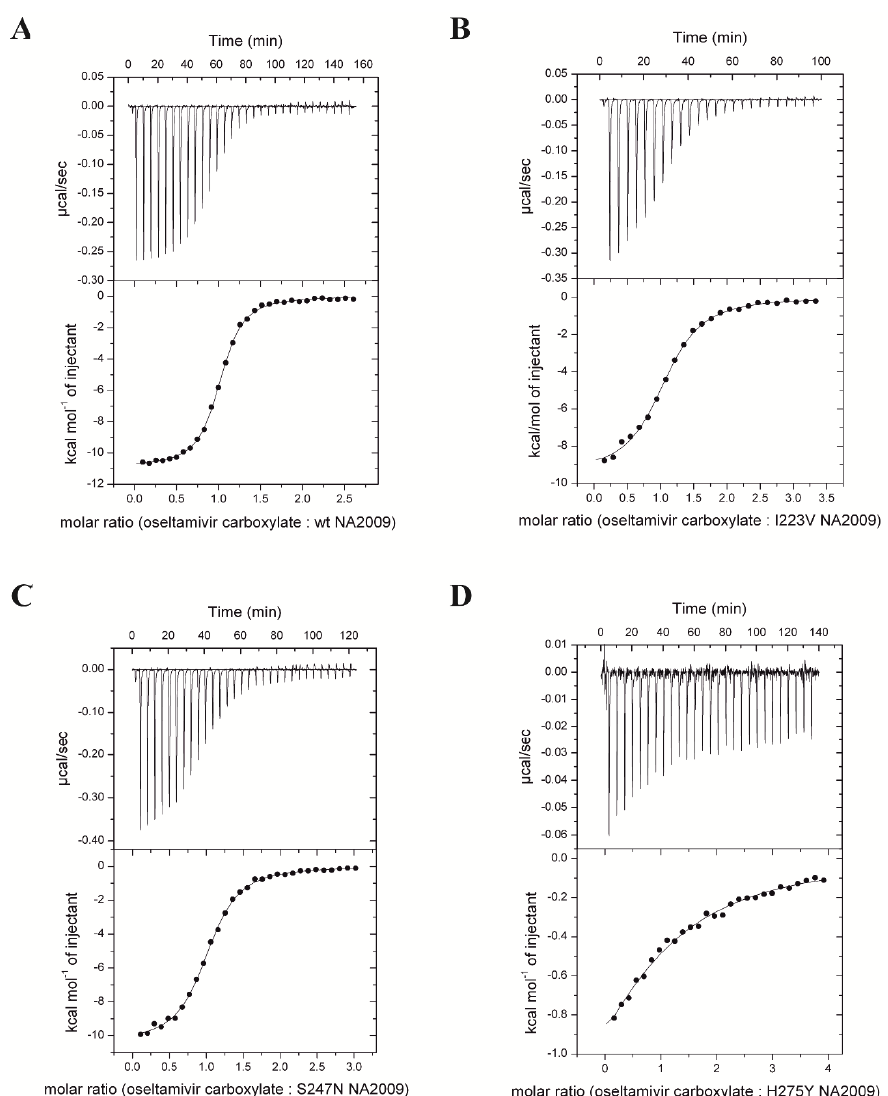
Figure 1. Thermodynamic analyses of oseltamivir binding. Isothermal titrations of oseltamivir carboxylate to the catalytic domain of wild-type NA2009 ( A ), I223V NA2009 ( B ), S247N NA2009 ( C ), and H275Y NA2009 ( D ) performed in 50 mM MES, pH 6.15, 150 mM NaCl, 10 mM CaCl 2 at 25 °C.